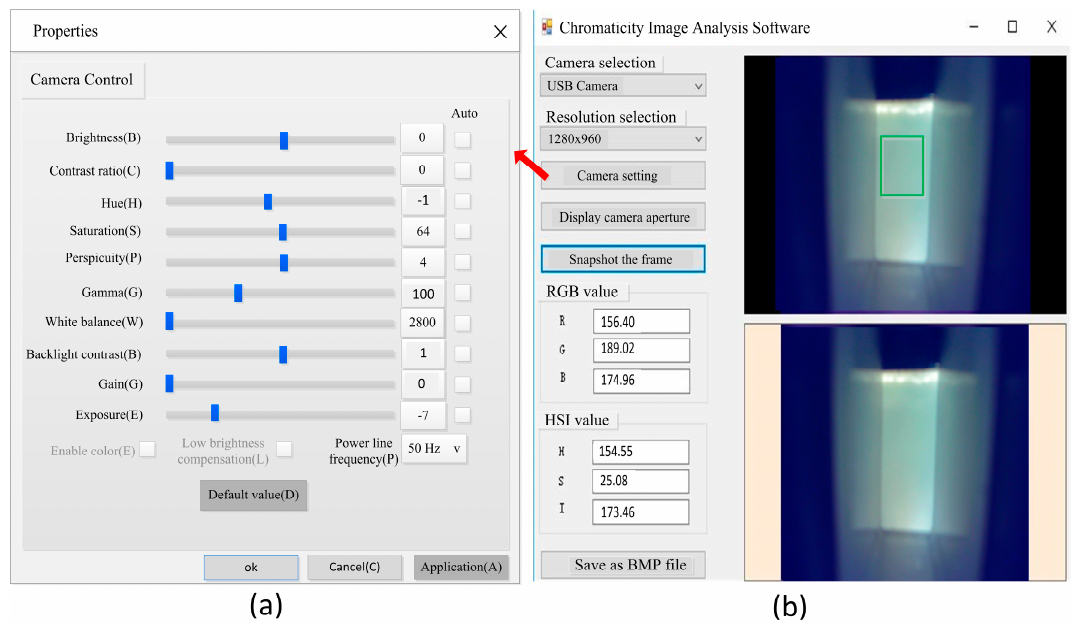
Figure 5. Software interface and camera property settings. ( a ) is the camera parameters of this experiment. ( b ) is the main interface of the image processing software.